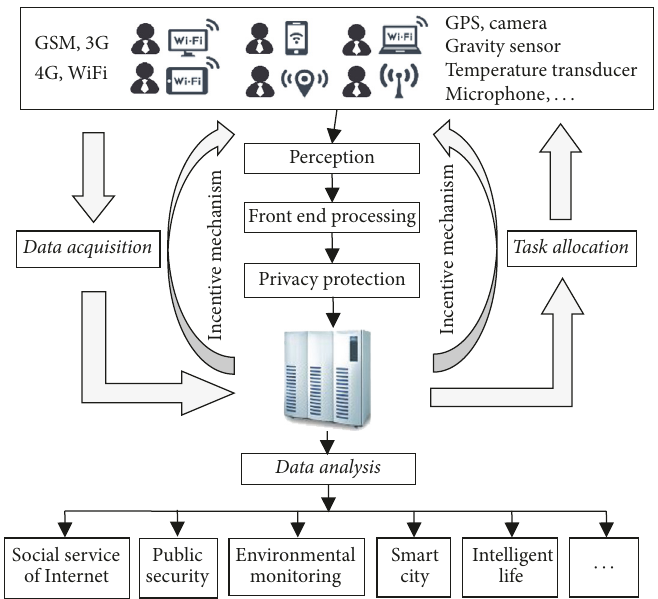
Figure 1: System structure diagram of mobile crowd sensing